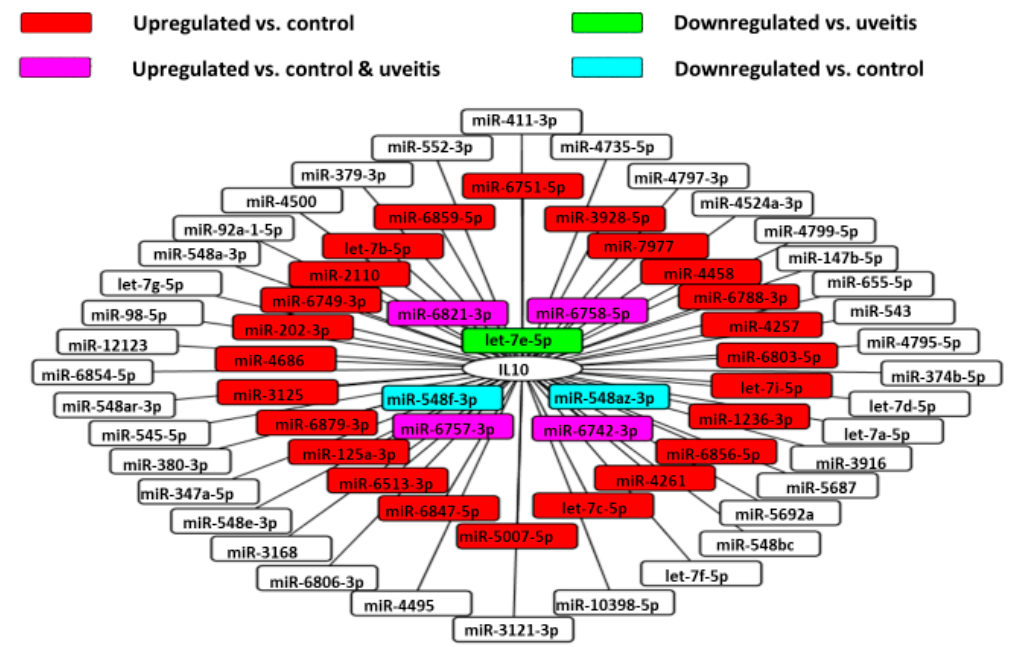
Figure 9. MiRNA-IL-10 gene interaction networks in VRL. 67 validated microRNAs having interactions Figure 9. MiRNA ‒ IL-10 gene interaction networks in VRL. 67 validated microRNAs having with IL-10 gene in the vitreous of VRL patients are interactions with IL-10 gene in the vitreous of VRL patients are shown.